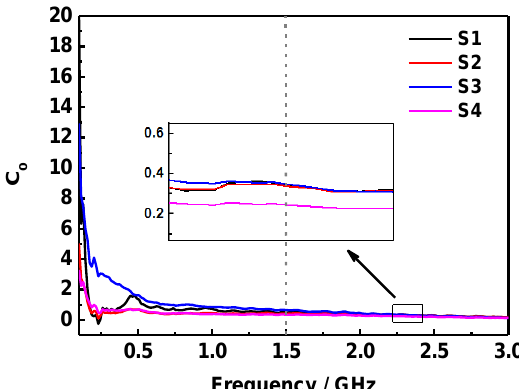
Figure 8. Frequency dependency of the eddy current loss curves of S1, S2, S3, and S4 at the thickness of 4 mm.